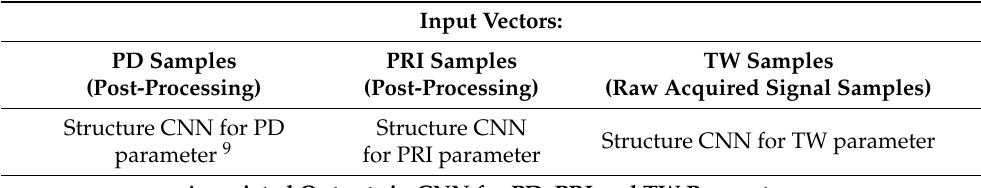
Table 4. Detailed structure of CNN designed for radar signal recognition with simultaneous input of three signal parameters (PRI, PD, TW).